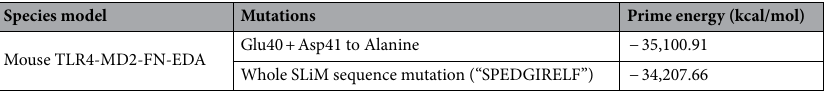
Table 5. Prime energies of the mouse FN-EDA model complexes obtained after mutations in SLiM